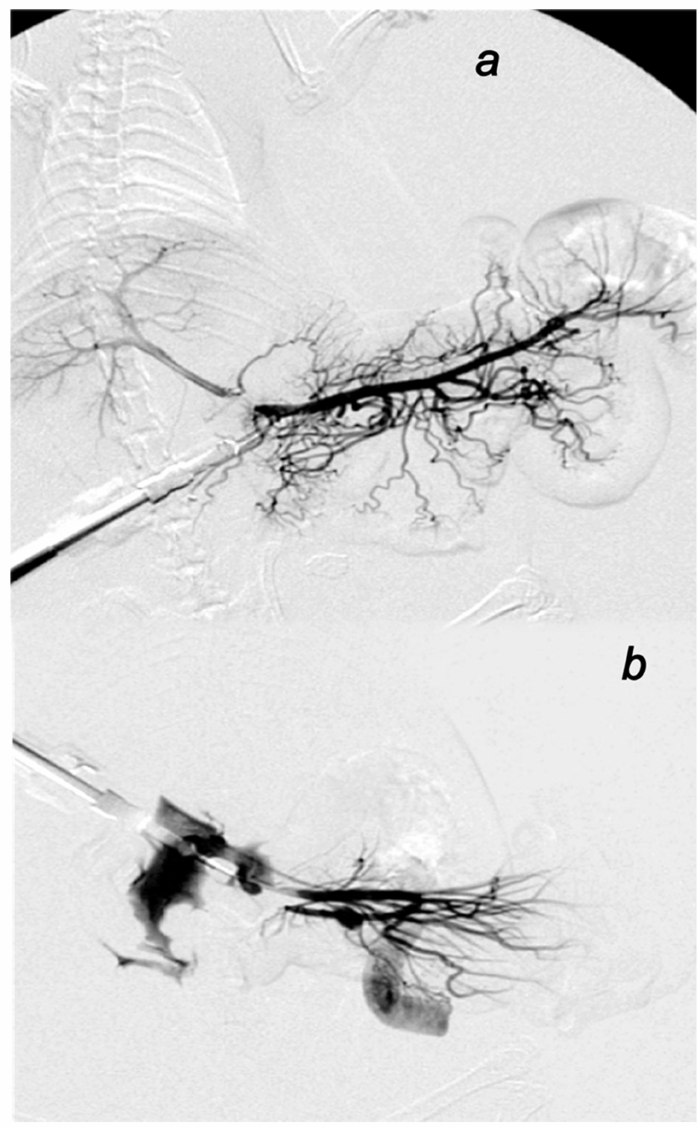
Figure 4. Venography. BPC 157 medication ( a ). After ligation of superior mesenteric vein, clear visualization of collaterals bypassing defect of superior mesenteric vein. Venography clearly showed the superior mesenteric vein–inferior anterior pancreaticoduodenal vein–superior anterior pancre- aticoduodenal vein–pyloric vein–portal vein pathway, reestablished superior mesenteric vein and portal vein connection and reestablished blood flow, the mesenterico-portal confluent and bypassing defect of superior mesenteric vein. Contrast flow into main portal trunk, portal bifurcation on the left and right portal vein and intraparenchymal portal branches on the porto-venous (or parenchymal) liver phase. Without medication, control rats ( b ) with the ligated superior mesenteric vein regularly show poor presentation in the venography (1 mL through 30 sec in the superior mesenteric vein). Commonly, they respond with the rapid rupture of the superior mesenteric vein and lack of the activated